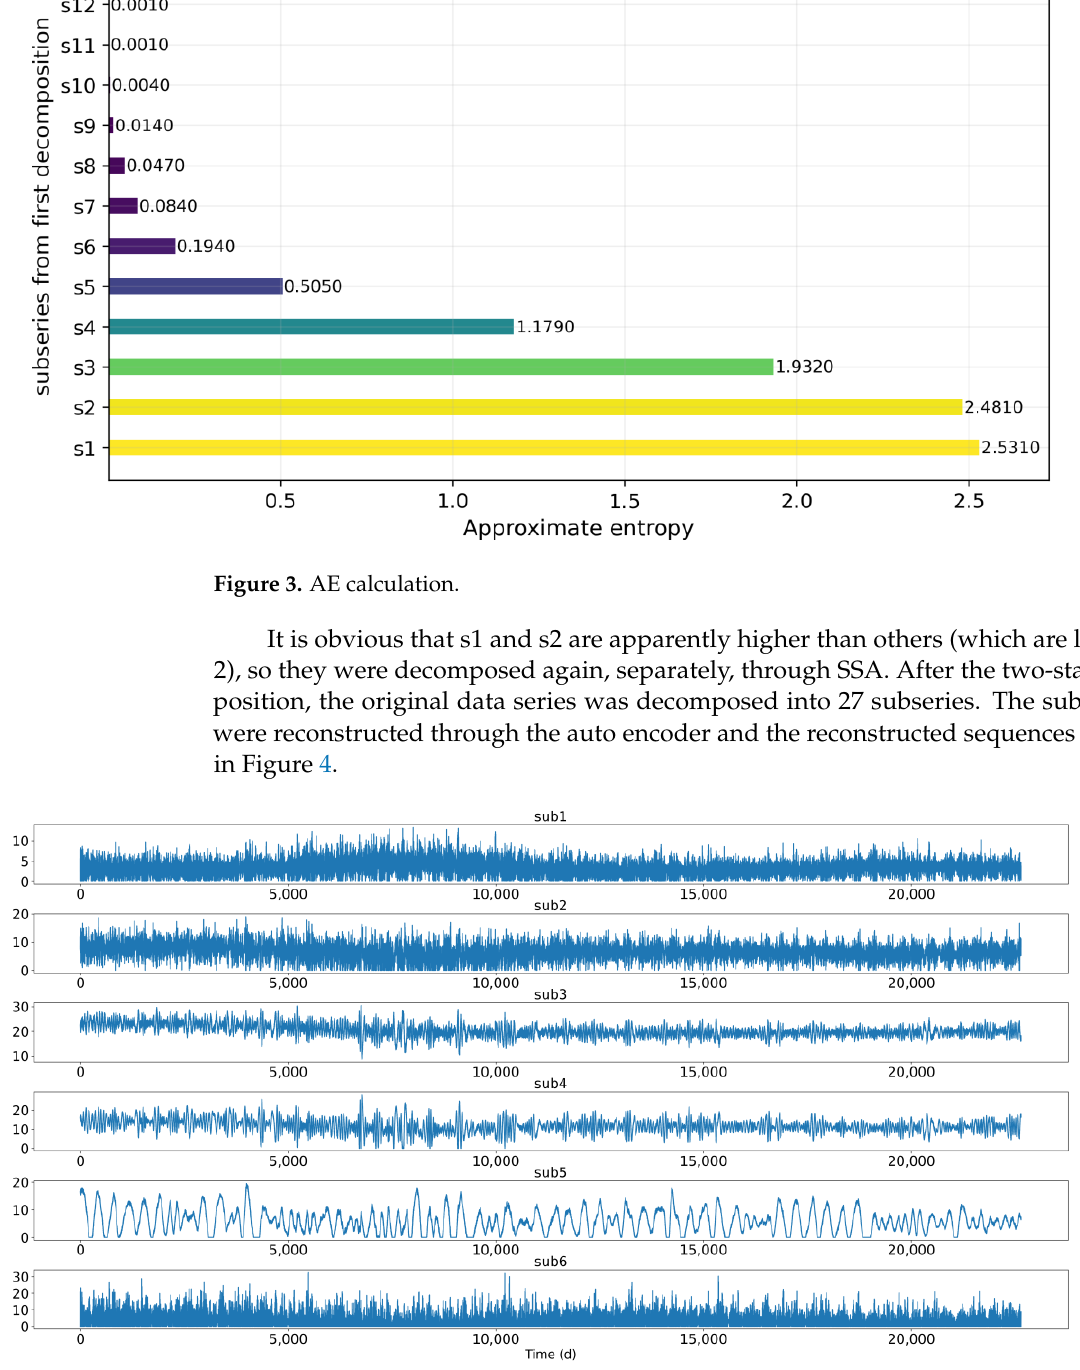
Figure 4. The six subfigures represent six subsequences which are generated through decomposi- tion and dimension reduction from the original time series in case 1. and dimension reduction from the original time series in case